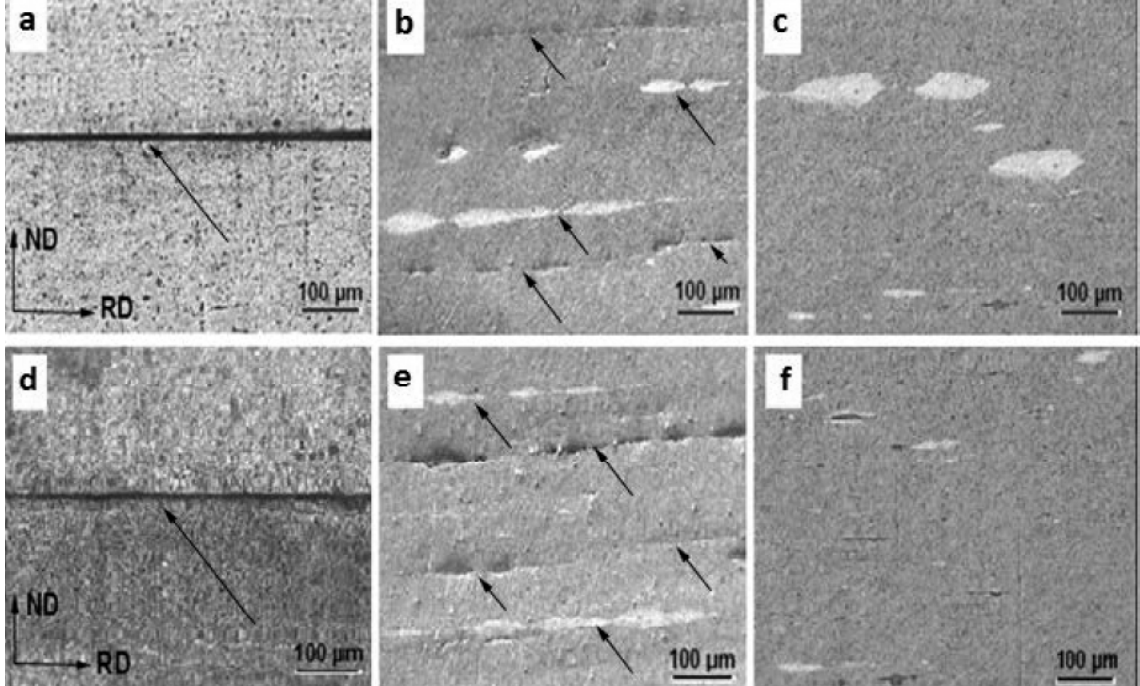
Fig. 4. The light micrographs of Al-0.5 wt.% TiO produced by first (a,d), third (b,e) and seventh (c,f) cycles of ARB process.